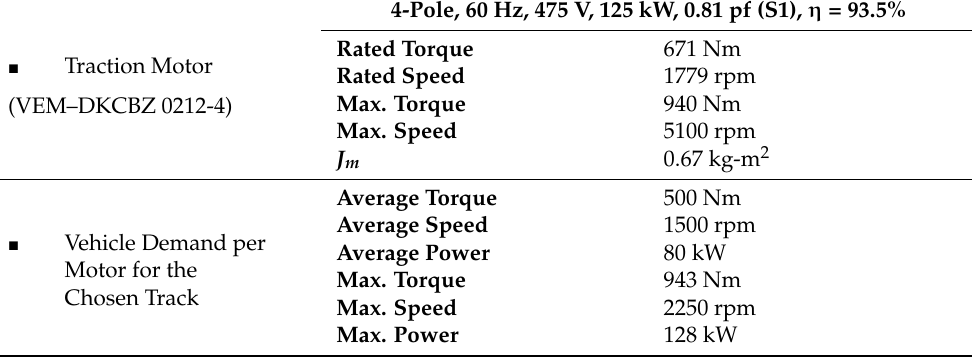
Table 2. Technical specifications of traction motor.